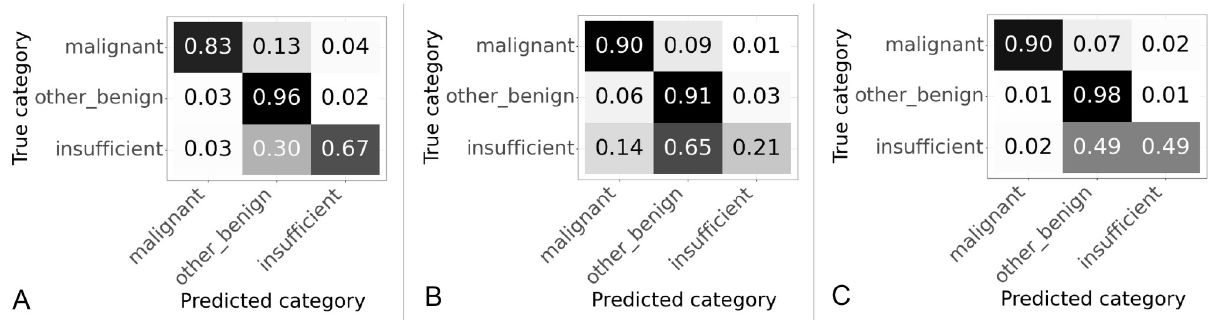
Fig 7. Confusion matrices for results on validation set using different patch sizes. Values are normalized over the true category. (A) Patch size 256 × 256 pixels. (B) Patch size 512 × 512 pixels. (C) Patch size 1024 × 1024 pixels.